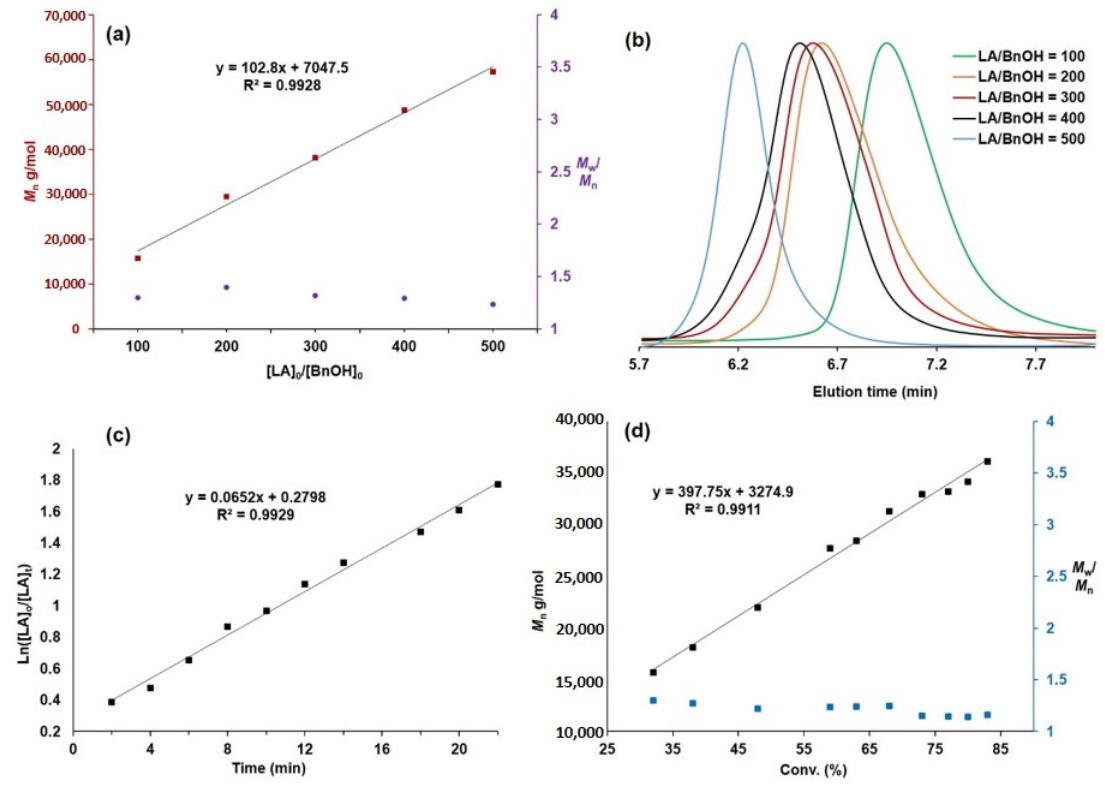
Figure 2. ( a ) Plot of PLAs: M n (GPC) and dispersity ( M w / M n ) vs. the molar ratio of monomer to initiator ([LA] 0 / [BnOH] 0 ) for the polymerization of rac -LA (run 1, 7–9, and 13, Table 1). ( b ) GPC traces of the polylactide prepared at di ff erent monomer ratios (run 1, 7–9, and 13, Table 1). ( c ) Semilogarithmic plots of ln([LA] 0 / [LA] t ) vs. time for rac -LA polymerization (run 8, Table 1). ( d ) M n (GPC) and dispersity (Ð) vs. monomer conversion for PLAs synthesized at room temperature (run 8, Table